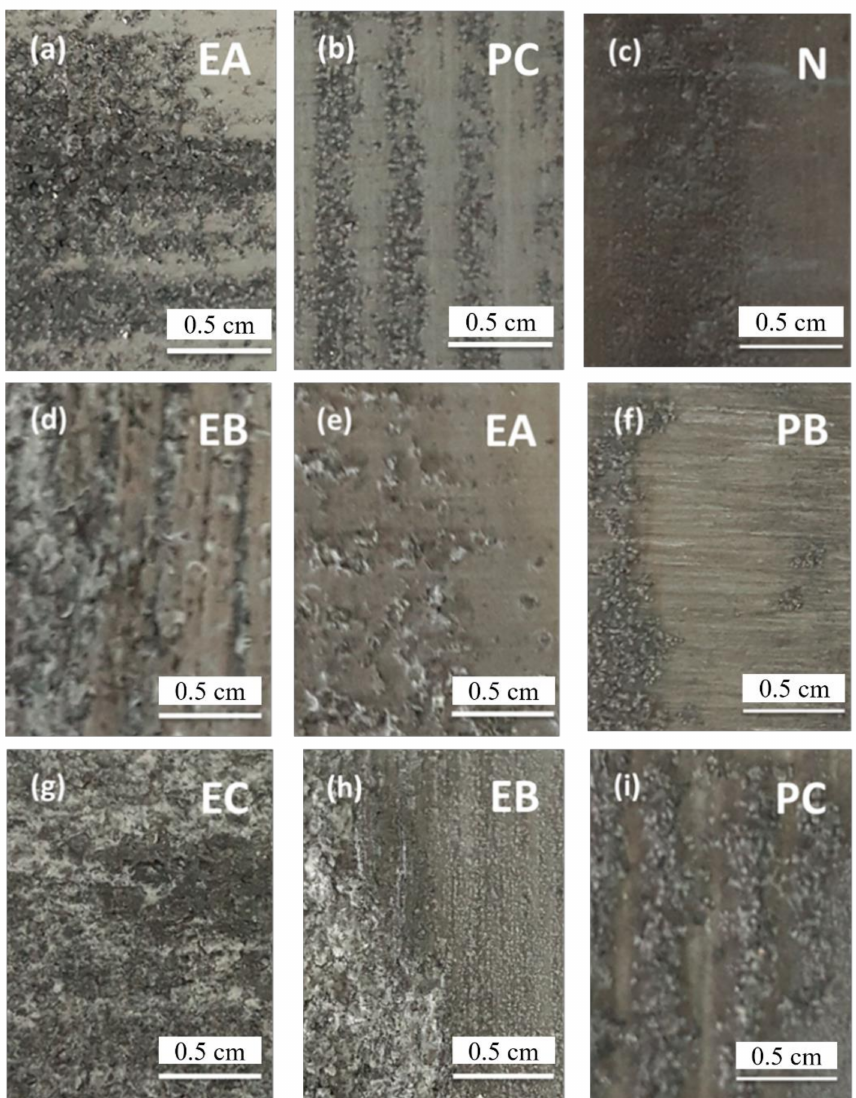
Figure 7. The corrosion morphologies of the 7N01 extrusion aluminum alloy at infiltrated 6 h with different aging: ( a ) single-peak aging; ( b ) two-stage aging; ( c ) non-isothermal aging; the corrosion morphologies of the 7N01 extrusion aluminum alloy at infiltrated 12 h with different aging: ( d ) single- peak aging; ( e ) two-stage aging; ( f ) non-isothermal aging; the corrosion morphologies of the 7N01 aluminum alloy at infiltrated 24 h with different aging: ( g ) single-peak aging; ( h ) two-stage aging; ( i ) non-isothermal